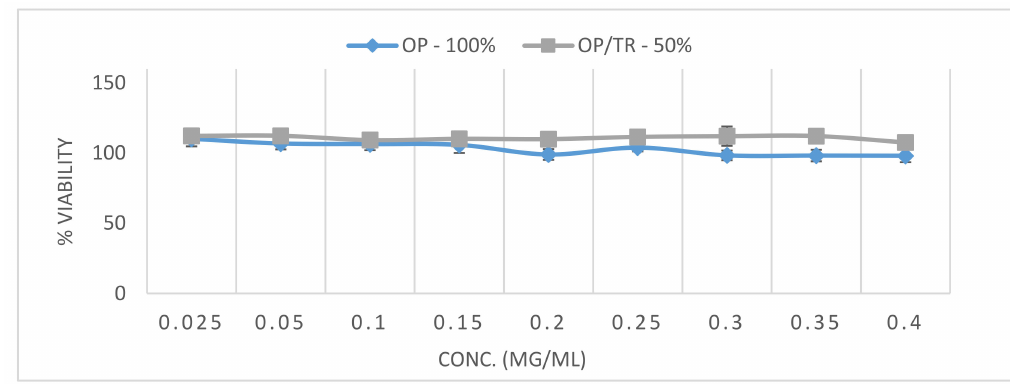
Figure 11. Viability percent of Calu3 cells after 4 h incubation with pure micronized OP (OP–100%) and micronized OP in combination with micronized trehalose particles in a 1:1 blend ratio (OP / TR–50%) at increasing concentrations from 0.025 up to 0.4 mg / mL for each solution. Error bars based on the calculated standard deviation from mean ( n =